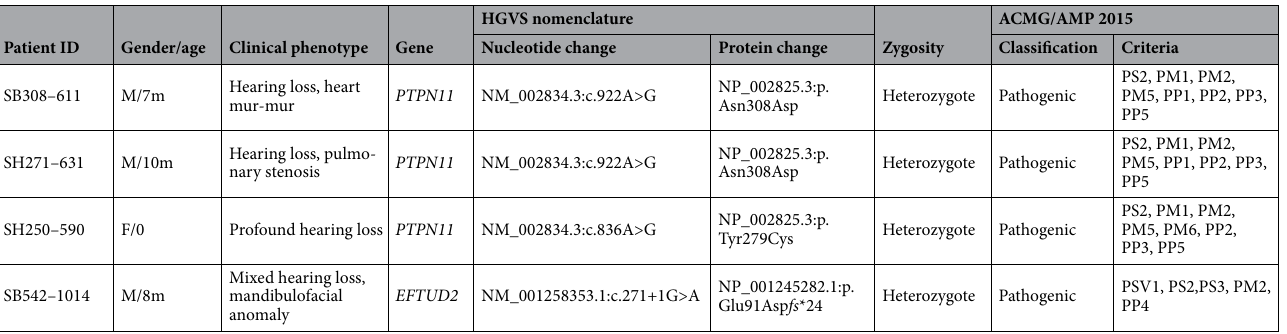
Table 4. The pathogenic variants detected exclusively by